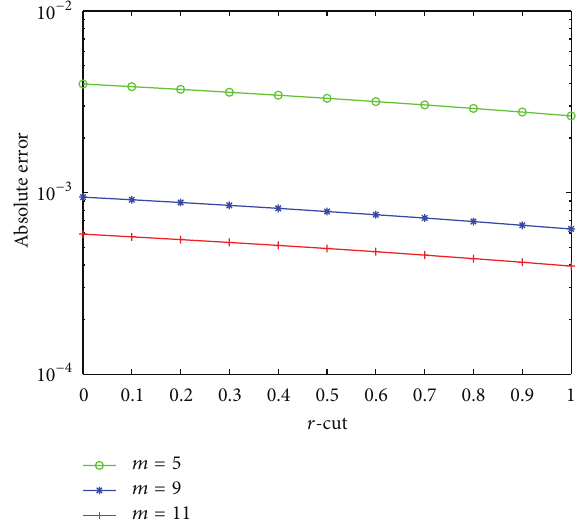
Figure 2: The absolute error for different 𝑚 of Example 52, Case 1. 𝛼 = 0.85 .